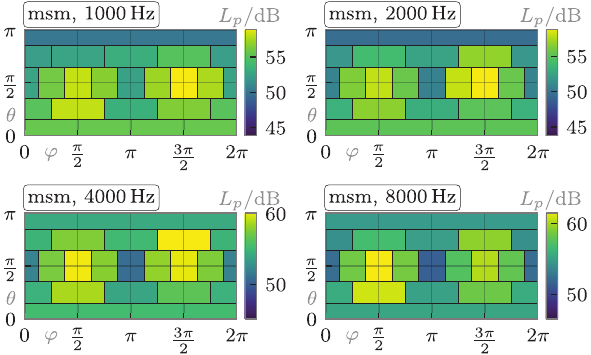
Figure 13. Directional sound radiation of the drone, evaluated with the ES 18 partitioning for several octave bands.